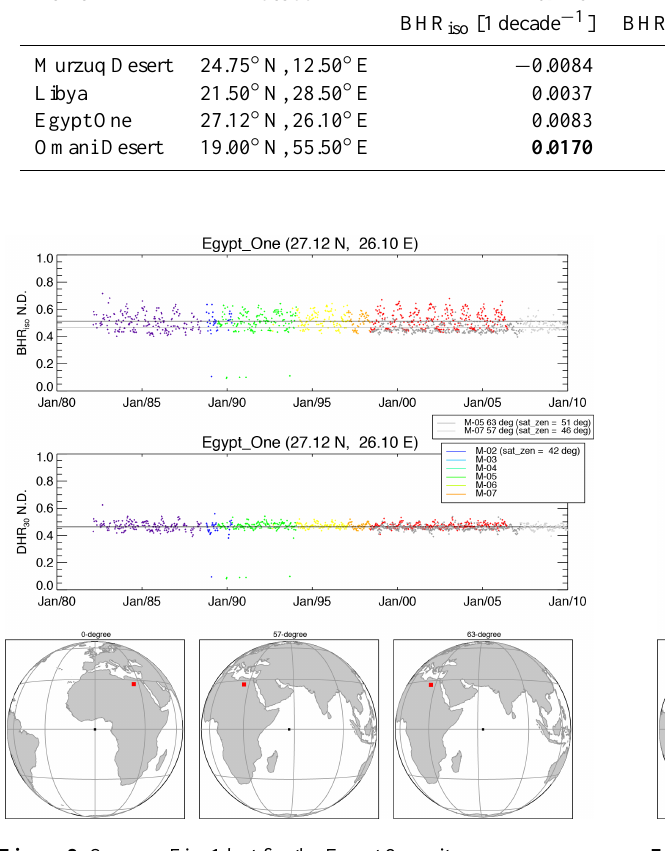
Figure 3. Same as Fig. 1 but for the Egypt One site. Figure 4. Same as Fig. 1 but for the Omani Desert site.